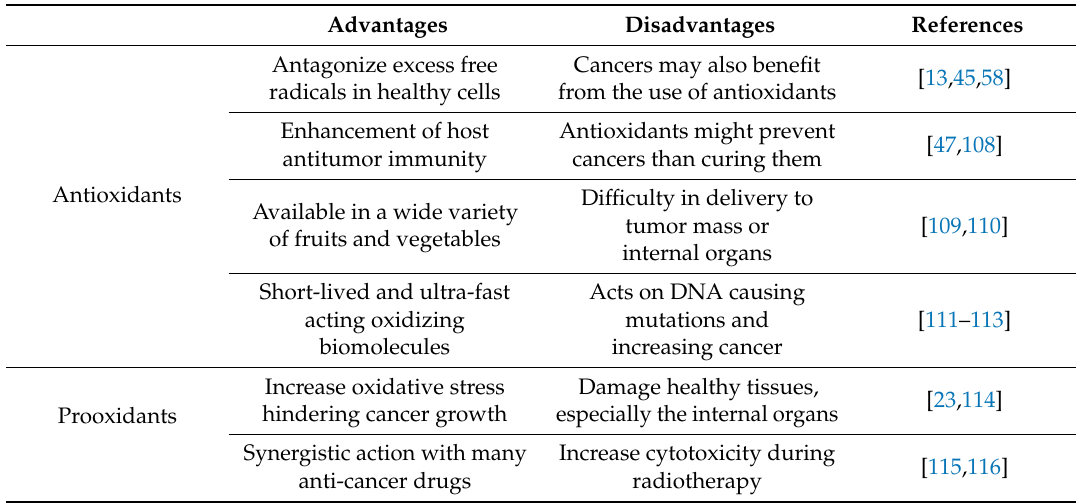
Table 2. Advantages and disadvantages of anti- and pro-oxidant therapies in cancer.